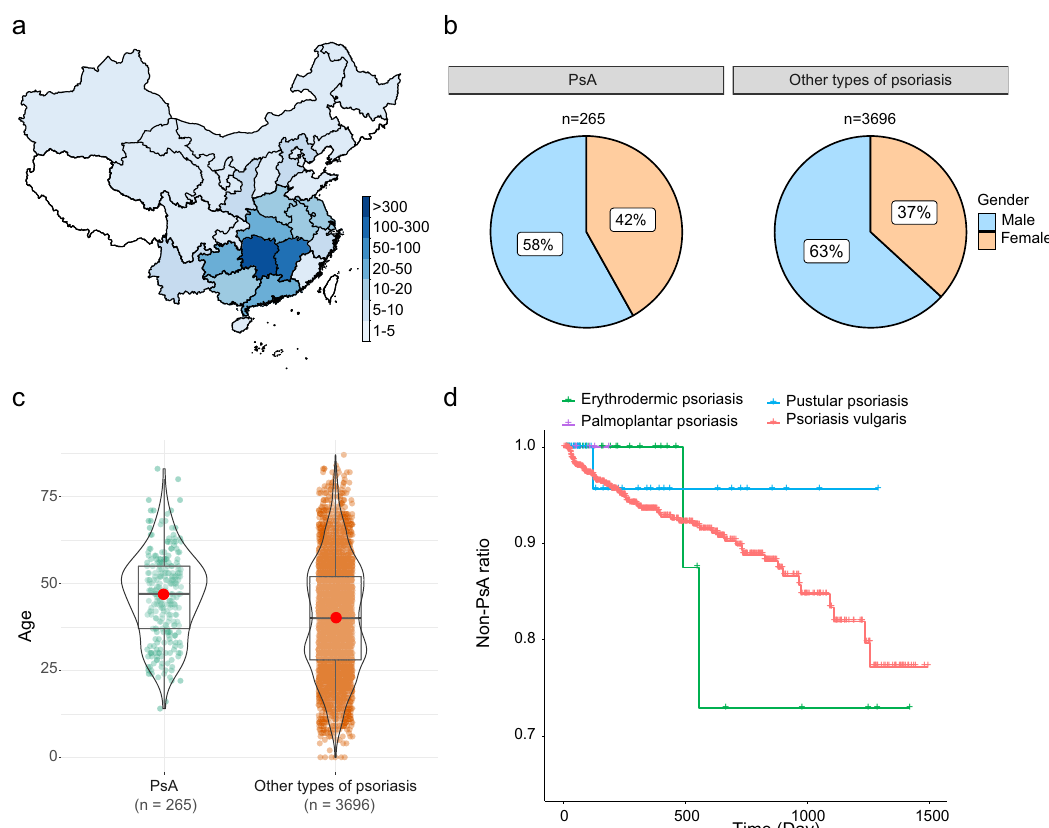
Fig. 1 An overview of the psoriasis dataset collected from Xiangya Hospital for this study. a The geographical distribution of patients with psoriasis. b A comparison of gender distributions between patients with PsA and non-PsA. c A comparison of age distributions between patients with PsA and non-PsA. The central line marks the median age value, and the bounds of the box mark the fi rst and third quartiles. d Development from other types of psoriasis to PsA within the